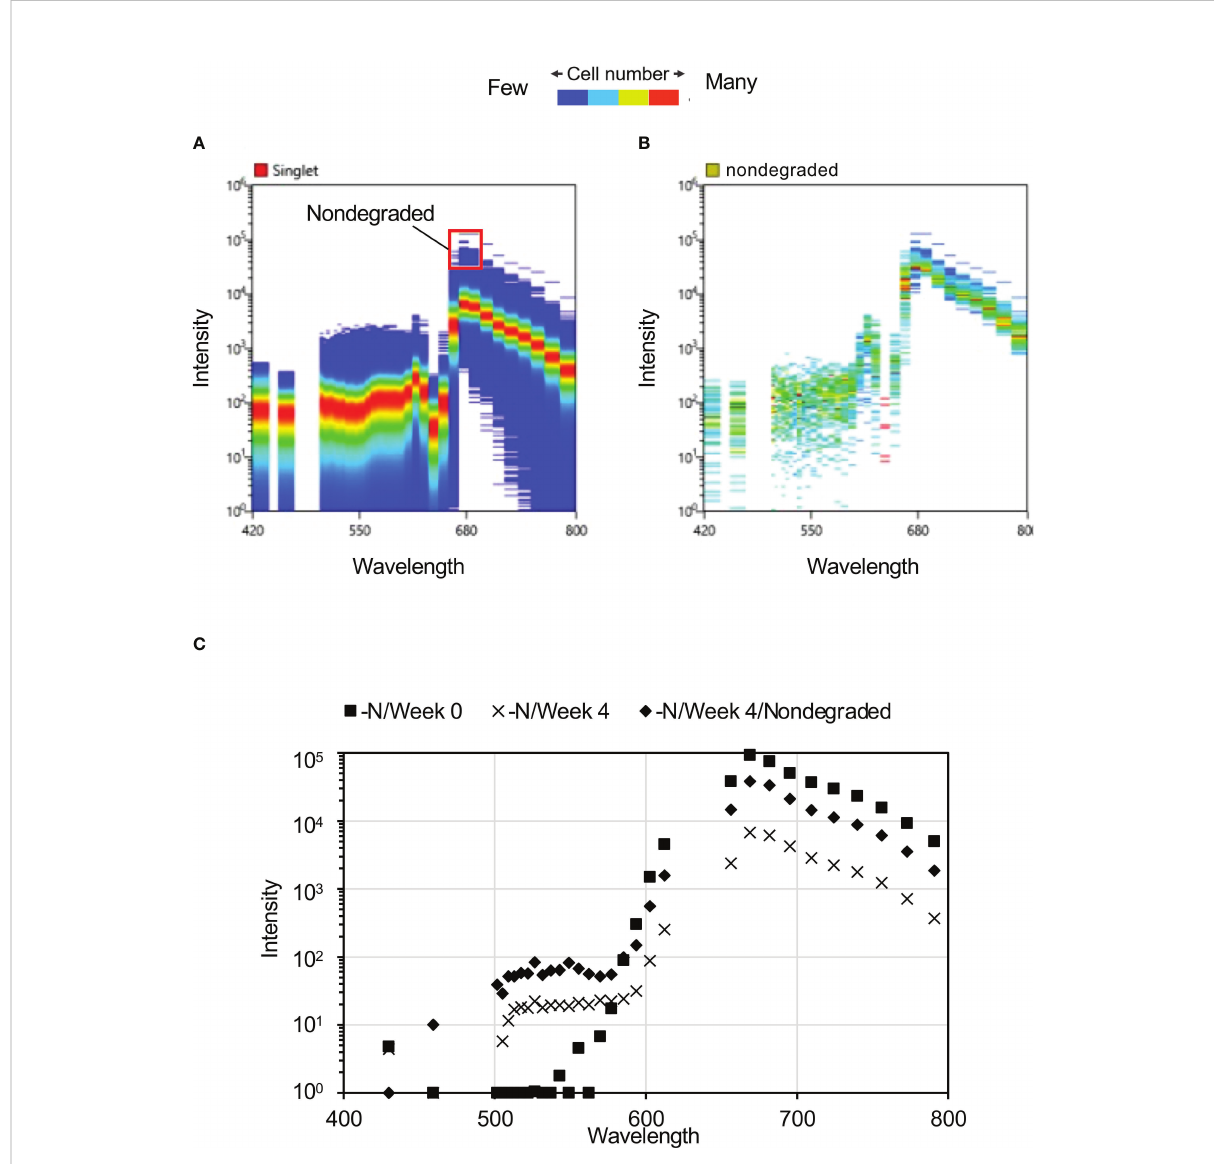
FIGURE 3 Auto fl uorescence spectra of cells after four weeks of N-depletion. (A) Auto fl uorescence spectrum derived from a single cell, after four weeks of N- depletion, based on 2,001,770 plots. The “ nondegraded ” group refers to cells with auto fl uorescence intensity of ca. 680 nm, where photosynthetic pigment was not substantially reduced by four weeks of N-depletion; it comprises 0.0057% of the total number of cells measured. (B) Auto fl uorescence spectrum of 115 “ nondegraded ” cells. (C) Average auto fl uorescence intensity of each culture. – N/Week 0 and – N/Week 4: average auto fl uorescence intensities at each wavelength for whole single cells, after zero and four weeks of N-depletion, respectively. nondegraded: average auto fl uorescence intensities at each wavelength for the nondegraded group after four weeks of